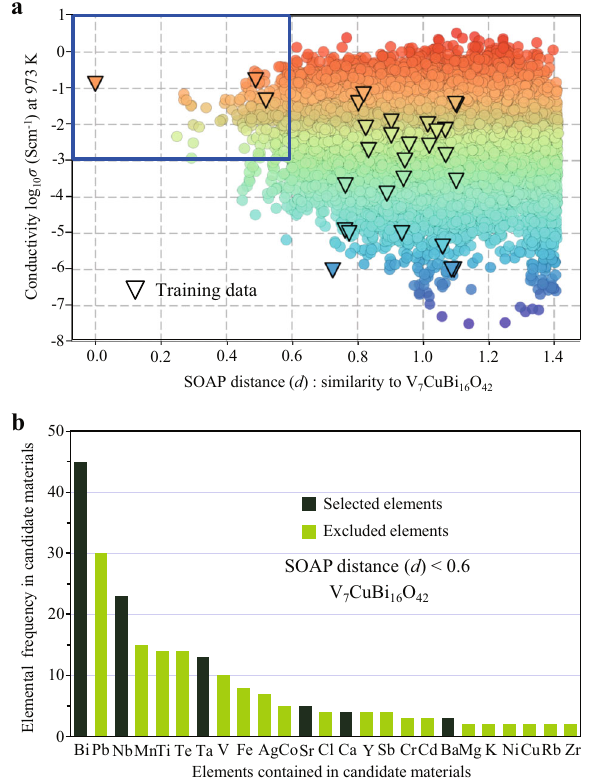
Fig. 2 The results of virtual screening based on our machine learning model. a Selection of the candidate materials having the SOAP distance less than 0.6 with respect to V 7 CuBi 16 O 42 and the predicted conductivity higher than 10 − 3 S cm − 1 . The marks ( ∇ ) locate training data and the red colour indicates higher conductivity in the map. b Selected elements based on elemental frequency appeared in the candidate